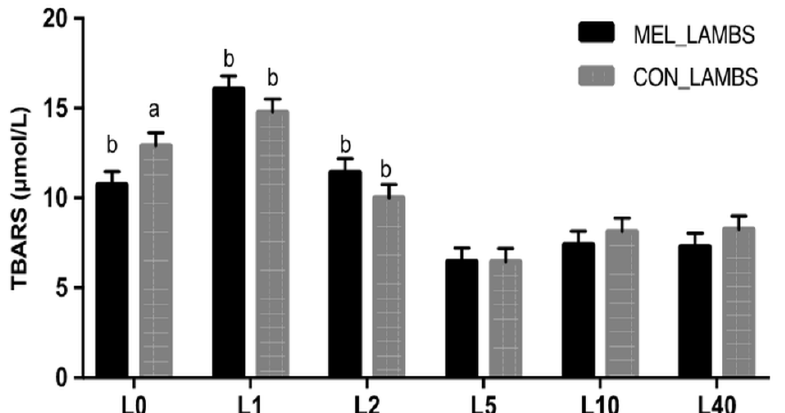
Figure 4. Least squares means ± SEM of lipid peroxidation (TBARS, μmol/L) in lambs’ plasma, in control group (CON) and in melatonin group (MEL), at birth (L0) and on days 1 (L1), 2 (L2), 5 (L5), 10 (L10) and 40 (L40) of their life, p < 0.05, a: among the two groups, b: within time.